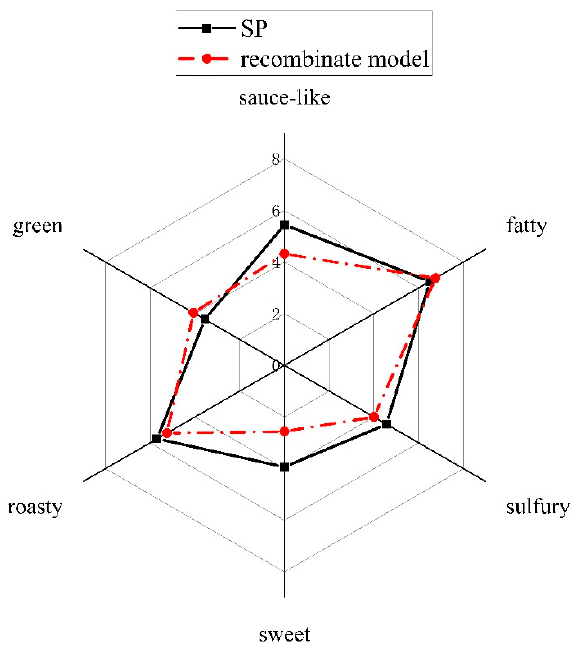
Figure 2. Quantitative descriptive analysis between SP and recombinate model.